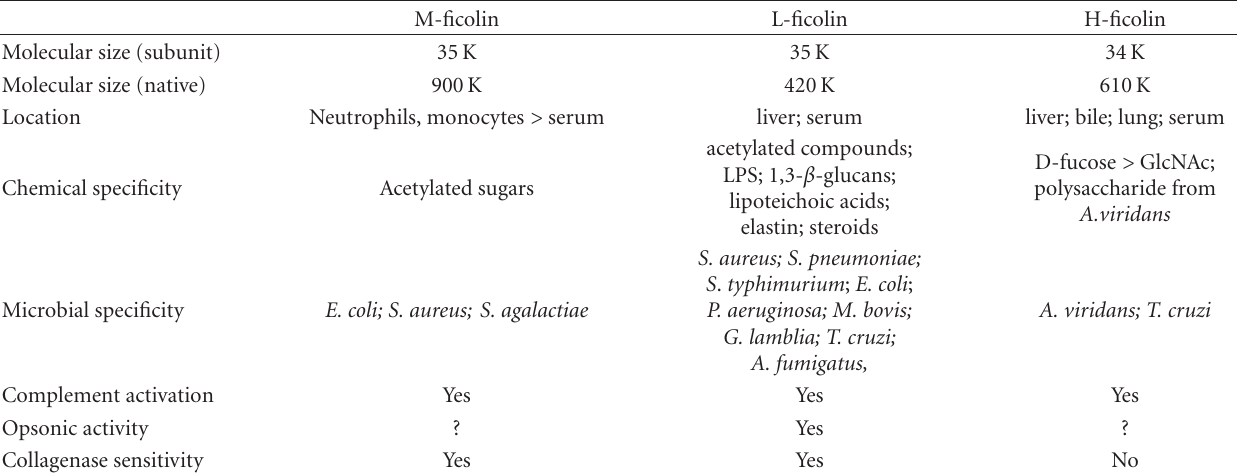
Table 1: The human